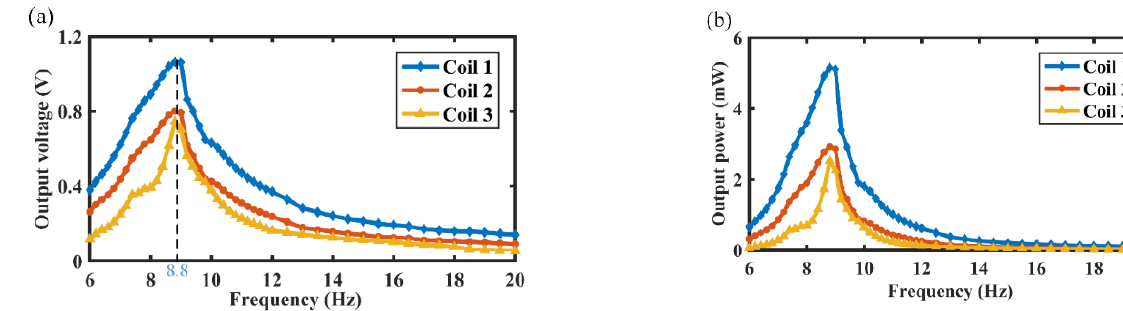
Figure 3. The curve of the MEECH output with excitation frequency: ( a ) the curve of the output voltage with the excitation frequency; ( b ) the curve of the output power with the excitation frequency.